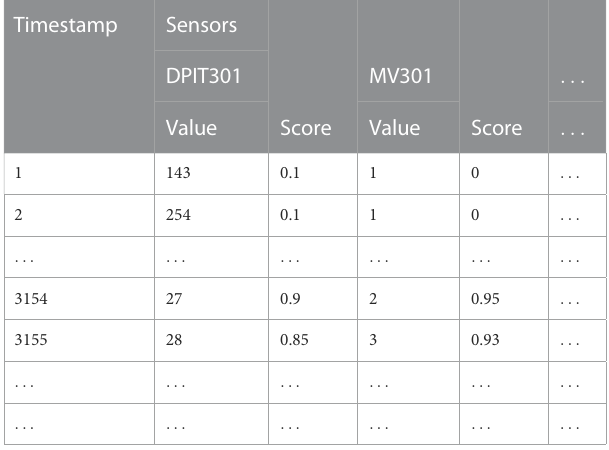
TABLE 1 We applied the Matrix Pro fi le Algorithm to detect anomalies on every sensor of the SWaT Dataset. Each sensor has a certain value and an abnormality score associated with each timestamp (one per